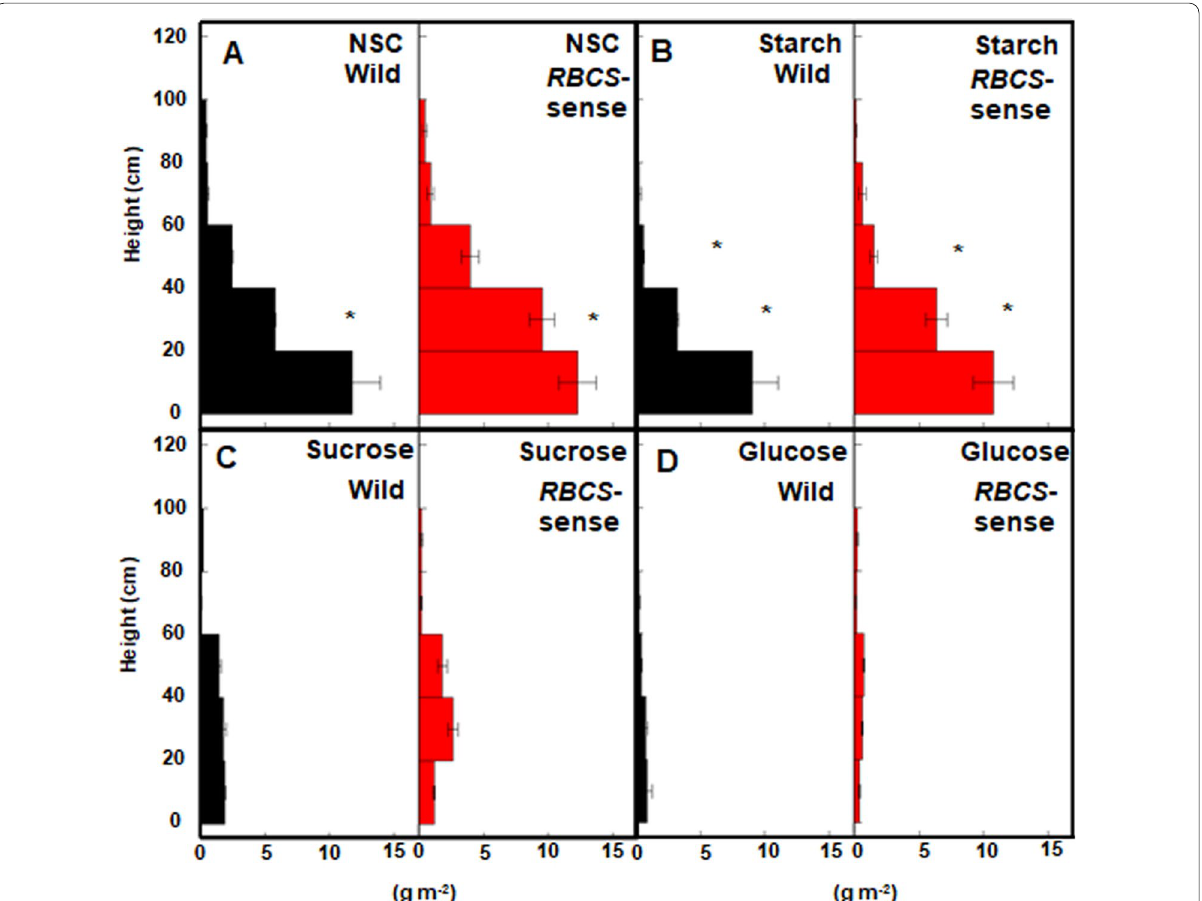
Fig. 7 The vertical distribution of the contents of nonstructural carbohydrates (NSCs) in the leaf sheaths and stems of wild‑type and RBCS ‑sense rice plants in the canopies at 49 DAH in the late‑ripening stage in the plots with 15 g N m − 2 fertilizer. The contents of NSCs ( A ) starch ( B ), sucrose ( C ), and glucose ( D ) are indicated. Mean values the standard error of three independent plots are shown. * p < 0.05 between the wild‑type and ± RBCS ‑sense rice plants using Student’s t- test. The wild‑type and RBCS ‑sense rice plants are represented by black and red bars, respectively. The abbreviations stand as follows: NSC; nonstructural carbohydrates, “ RBCS ‑sense”; transgenic rice plants overproducing Rubisco, “Wild”; wild‑type rice